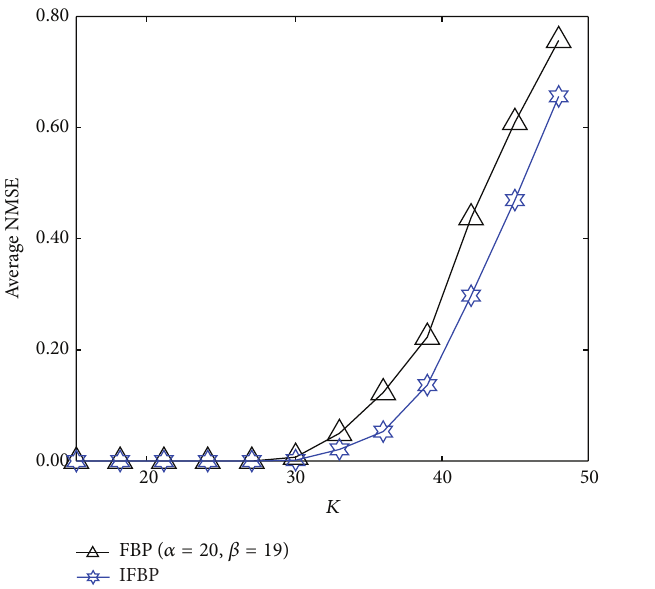
Figure 5: Exact recovery rates for the Gaussian sparse vectors ( 𝛼 = 30 , 𝛽 = 29 ).